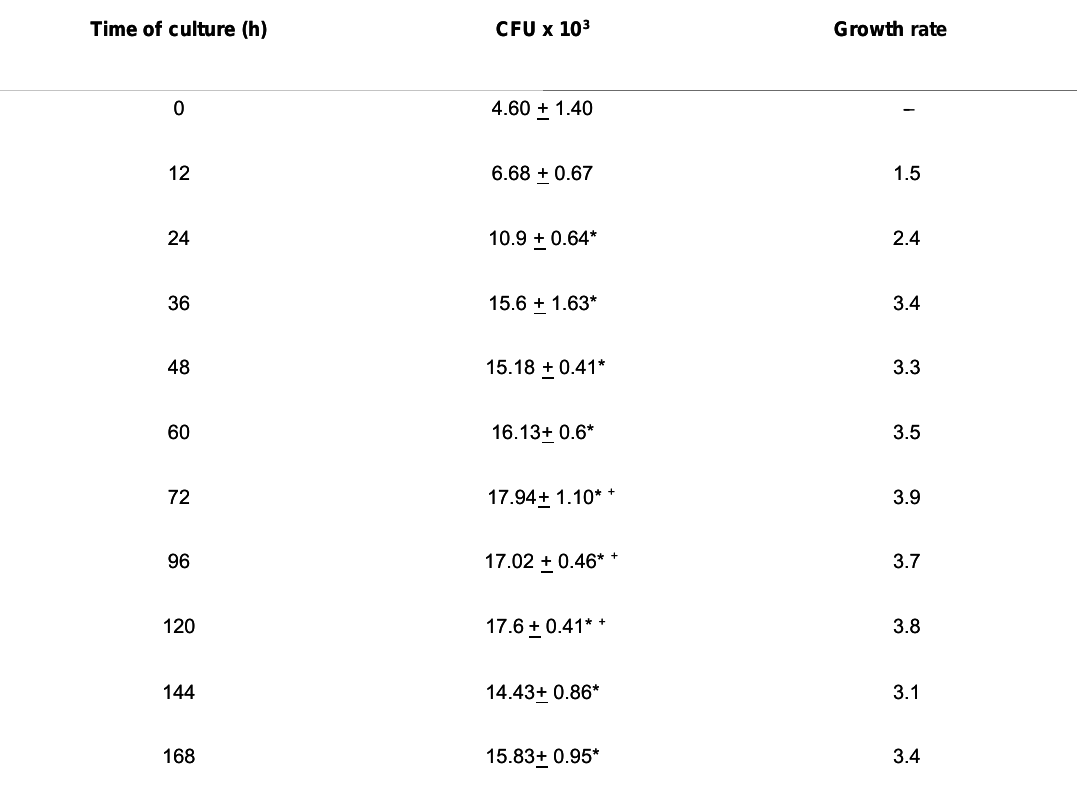
Table 1. Viable Paracoccidioides brasiliensis yeast cells recovery at different moments of